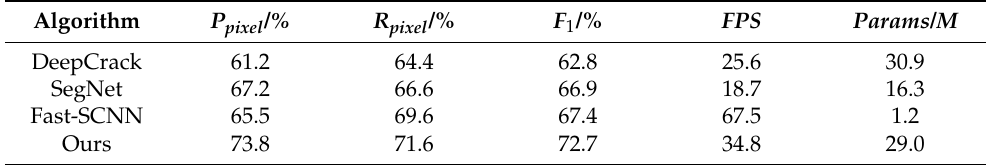
Table 4. Performance comparison of different crack detection